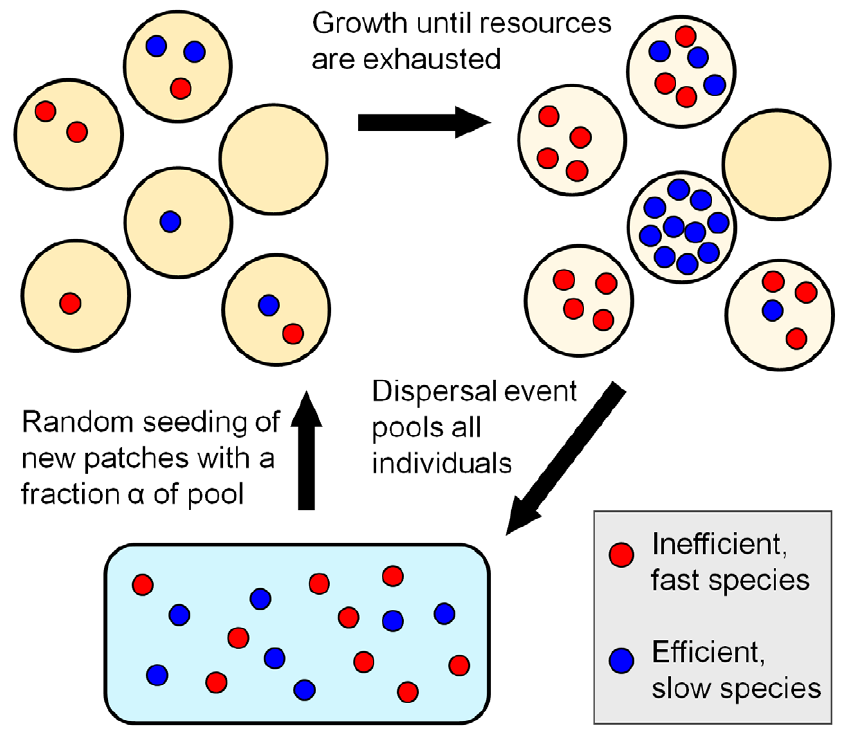
Figure 1. A grow-and-disperse patch model of competition for a single resource. Individuals (red, blue dots) are randomly distributed on identical nutrient patches (yellow discs) and grow exponentially until the single resource on their patch is exhausted. Once growth has ceased on all patches, a dispersal event collects all individuals into a seeding pool. The cycle then starts anew by seeding new patches with a fraction a of the individuals from the seeding pool. Each species is defined by two properties: its growth rate on a patch ( m ) and its efficiency in turning resources into offspring ( Y , number of offspring per patch in the absence of competitors) – for clarity, only two species are shown. An efficient but slow species (blue dots) grows to high densities when not subject to strong intra-patch competition, while the faster, inefficient species (red dots) has an advantage when competing with the slower species on the same patch. Since the seeding pool depends on the outcome of the previous round, a feedback loop regulates the selective pressure (see main